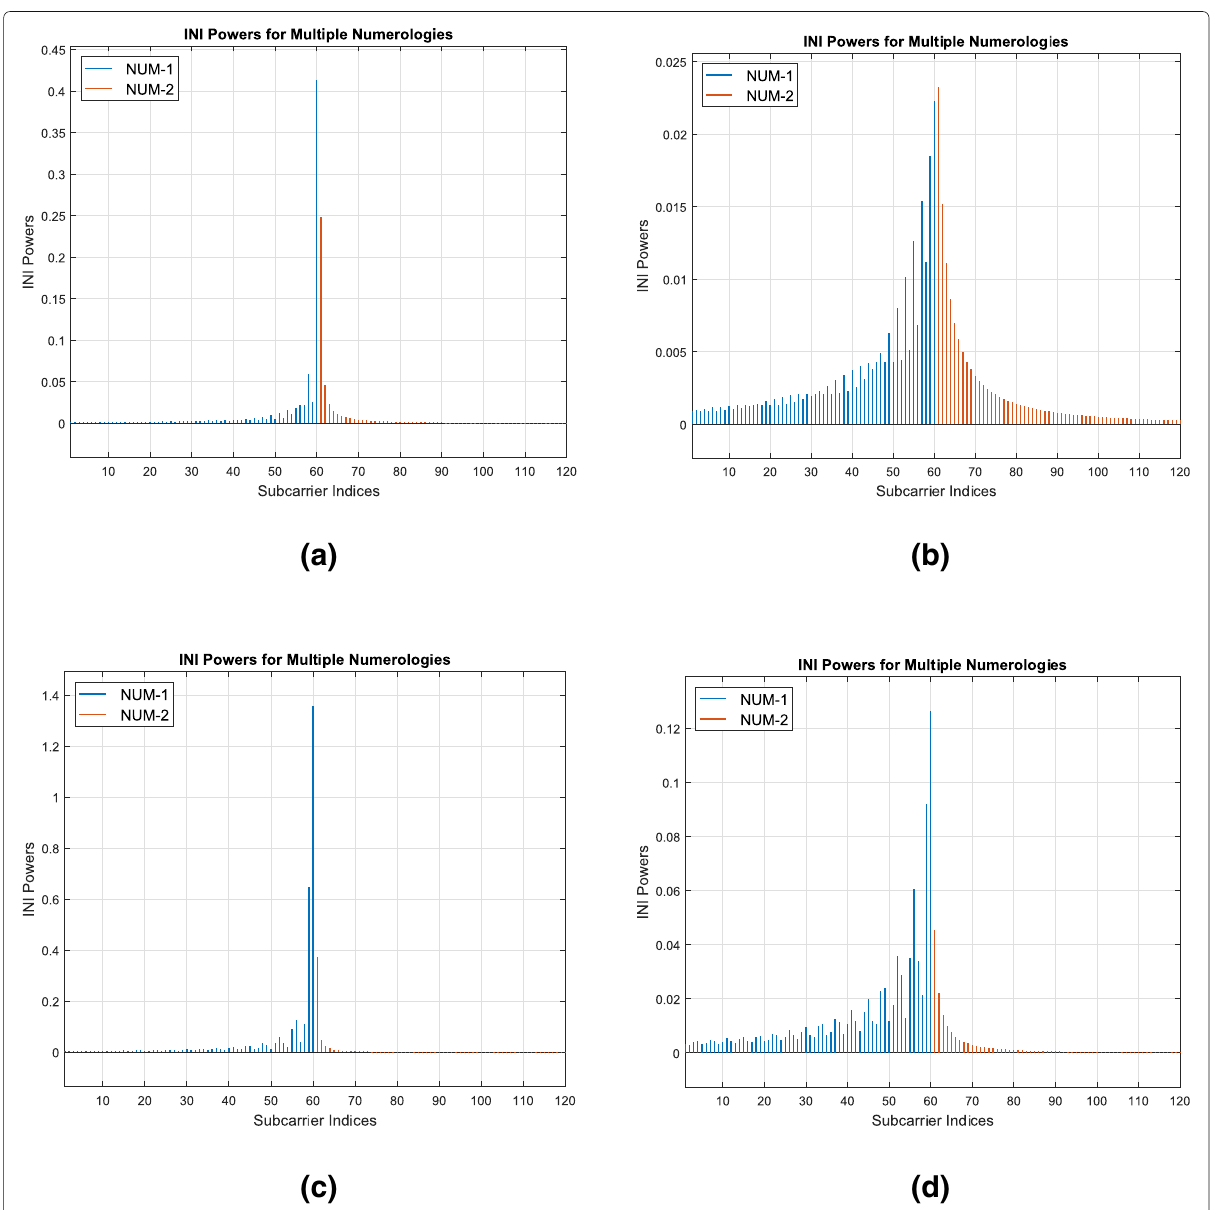
Fig. 4 INI analysis results regarding Eqs. 1 and 2 for multiple numerologies with different subcarrier spacings and guard bands. a NUM-1 has narrow SCs with 15 kHz, and NUM- 2 has wide SCs with 30 kHz. There is not any GBs between the numerologies. b NUM-1 has narrow SCs with 15 kHz, and NUM-2 has wide SCs with 30 kHz. There are four SCs as GBs between the numerologies. c NUM-1 has narrow SCs with 15 kHz, and NUM- 2 has wide SCs with 60 kHz. There is not any GBs between the numerologies d NUM-1 has narrow SCs with 15 kHz, and NUM-2 has wide SCs with 60 kHz. There are four SCs as GBs between the